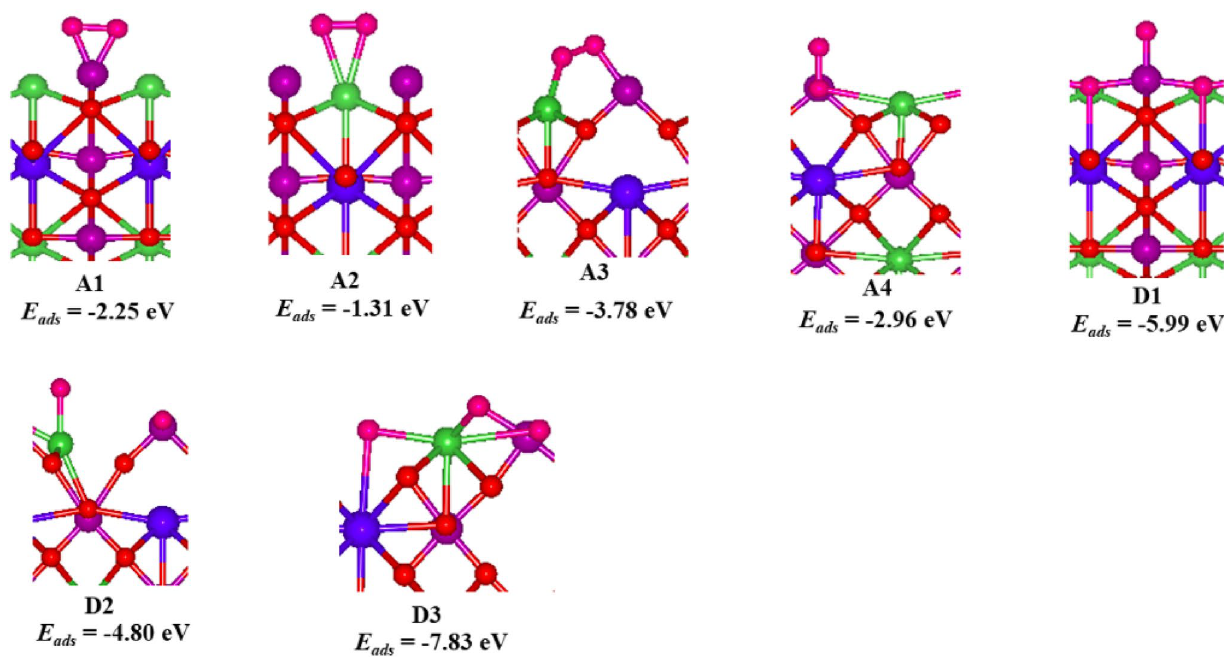
Fig. 3 Side view of the optimized geometries of oxygen molecule on (1 × 1) defective LBM25 {110}. Color code: green = La, blue = Ba, pur- ple = Mn, and red = O